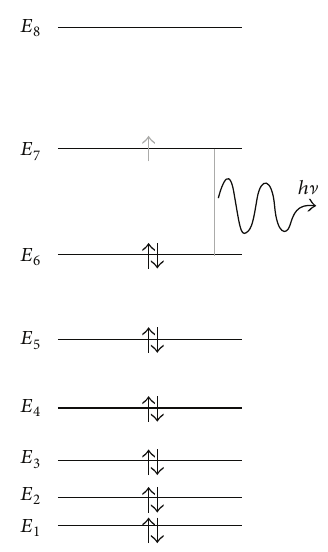
Figure 2: Population of the energy levels of the 𝜋